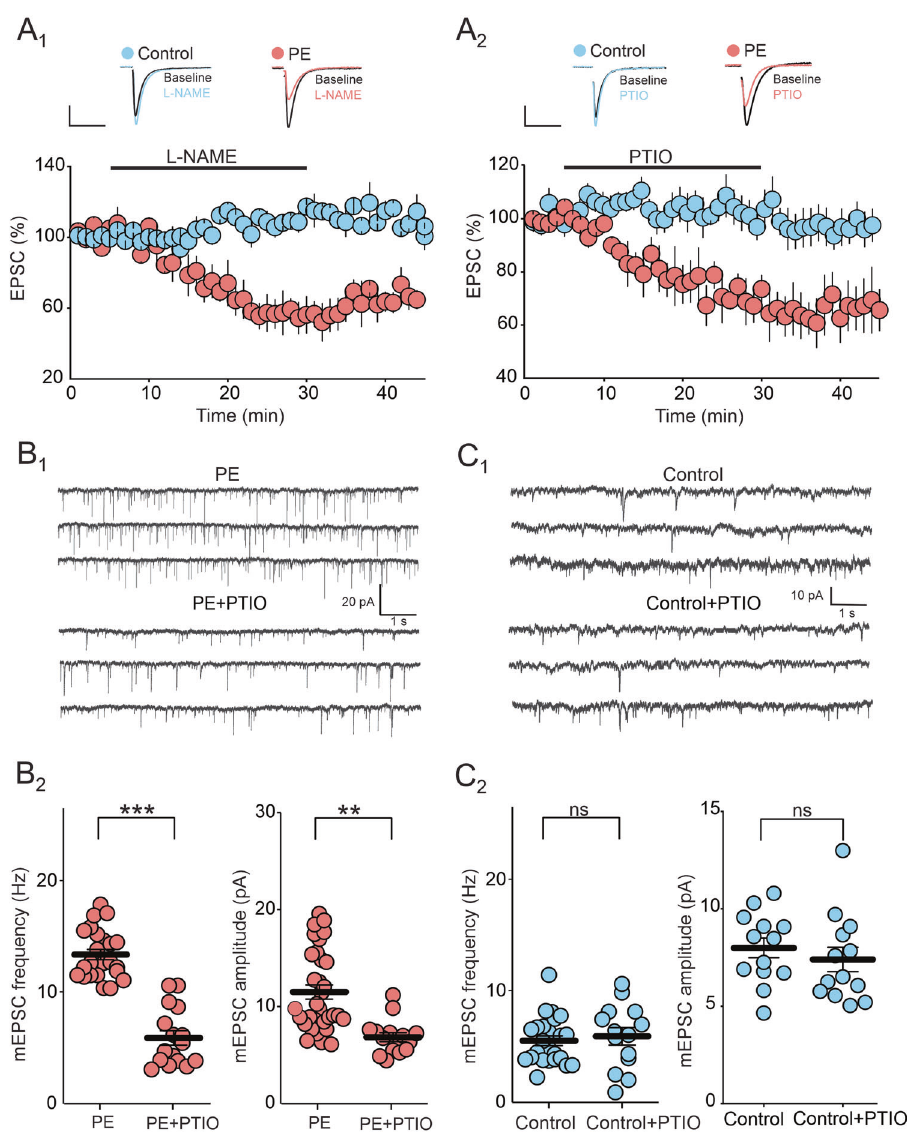
Fig. 4 Increased tonic NO signaling contributes to PE-induced potentiation of DRn glutamate synapses. A Inhibition of tonic NO signaling depresses the amplitude of EPSCs in PE, but not in control rats. A 1 The NOS inhibitor L-NAME inhibits the amplitude of EPSCs only in PE rats. Lower panel is a time-course summary of normalized EPSC amplitude depicting the depression of EPSC amplitude induced by L-NAME (100 µM) in PE ( , n = 8, N = 4 from 2 litters, paired t-test: p < 0.01, vs baseline), but not in control rats ( , n = 9, N = 4 from 2 litters, paired t-test: p > 0.05, vs baseline). Upper panel illustrates representative EPSC traces taken before (1) and during L-NAME application (2). Scale bars: 25 pA, 10 ms. A 2 The NO scavenger PTIO depresses the amplitude of EPSCs in PE, but not in control rats. Lower panel depicts the depression of EPSC amplitude induced by PTIO (100 µM) in PE ( , n = 9, N = 4 from 2 litters, paired t-test: p < 0.05, vs baseline) compared to control ( , n = 8, N = 4 from 2 litters, paired t-test: p > 0.05, vs baseline). Upper panel represents sample EPSC traces collected before (1) and during PTIO application (2). Scale bars: 25 pA, 10 ms. B Inhibition of tonic NO signaling reduces the frequency and the amplitude of mEPSCs in PE rats. B 1 Upper and lower graphs illustrate sample current traces recorded from PE rats in the absence and presence of PTIO (100 µM), respectively. Scale bars: 500 ms, 10 pA. B 2 Summary of the effects of PTIO on the frequency and amplitude of mEPSC in PE rats. Left graph represents scatter plots of mEPSC frequency recorded in PE rats in the absence (PE, n = 23, N = 8 from 4 litters) and presence of PTIO (PE + PTIO, n = 16, N = 5 from 3 litters, Mann-Whitney test: p < 0.001, PE vs PE + PTIO). Right panel depicts scatter plots of the average mEPSC amplitude recorded in PE rats in the absence (PE, n = 32, N = 10 from 5 litters) and presence of PTIO (PE + PTIO, n = 15, N = 5 from 3 litters, Mann-Whitney test: p < 0.01 PE vs PE + PTIO). ( C ) Inhibition of tonic NO signaling has no effect on the frequency and amplitude of mEPSCs in control rats. ( C 1 ) Sample current traces recorded from control rats in the absence and presence of PTIO (100 µM), respectively. ( C 2 ) Left panel illustrates the frequency of mEPSC recorded in the absence ( n = 24, N = 8 from 4 litters) and presence of PTIO ( n = 14, N = 5 from 3 litters, paired t-test: p > 0.05). Right panel depicts the amplitude of mEPSC recorded in the absence ( n = 33, N = 11 from 6 litters) and presence of PTIO ( n = 13, N = 6 from 3 litters, paired t-test: p > 0.05). n = number of cells, N = number of rats. p < 0.05, ɳ 2 = 0.50, PE vs PC; Fig. 5A PE: 108.57 ± 7.77 % of baseline; p < 0.05, ɳ 2 P = 0.78, PE vs PC; P 1 ). Next, we examined the effect of NO precursor L-Arg on eEPSC amplitude in control and Fig. 5B 1 ). The L-Arg induced potentiation of eEPSC amplitude PE rats and found that L-Arg increased the eEPSC amplitude in was mediated by an increase in glutamate release as indicated control, but not in PE rats (Control: 129.06 ± 4.29 % of baseline; by the decrease in PPR (Baseline: 1.24 ± 0.09; L-Arg: 1.11 ± 0.06; Translational Psychiatry (2022)